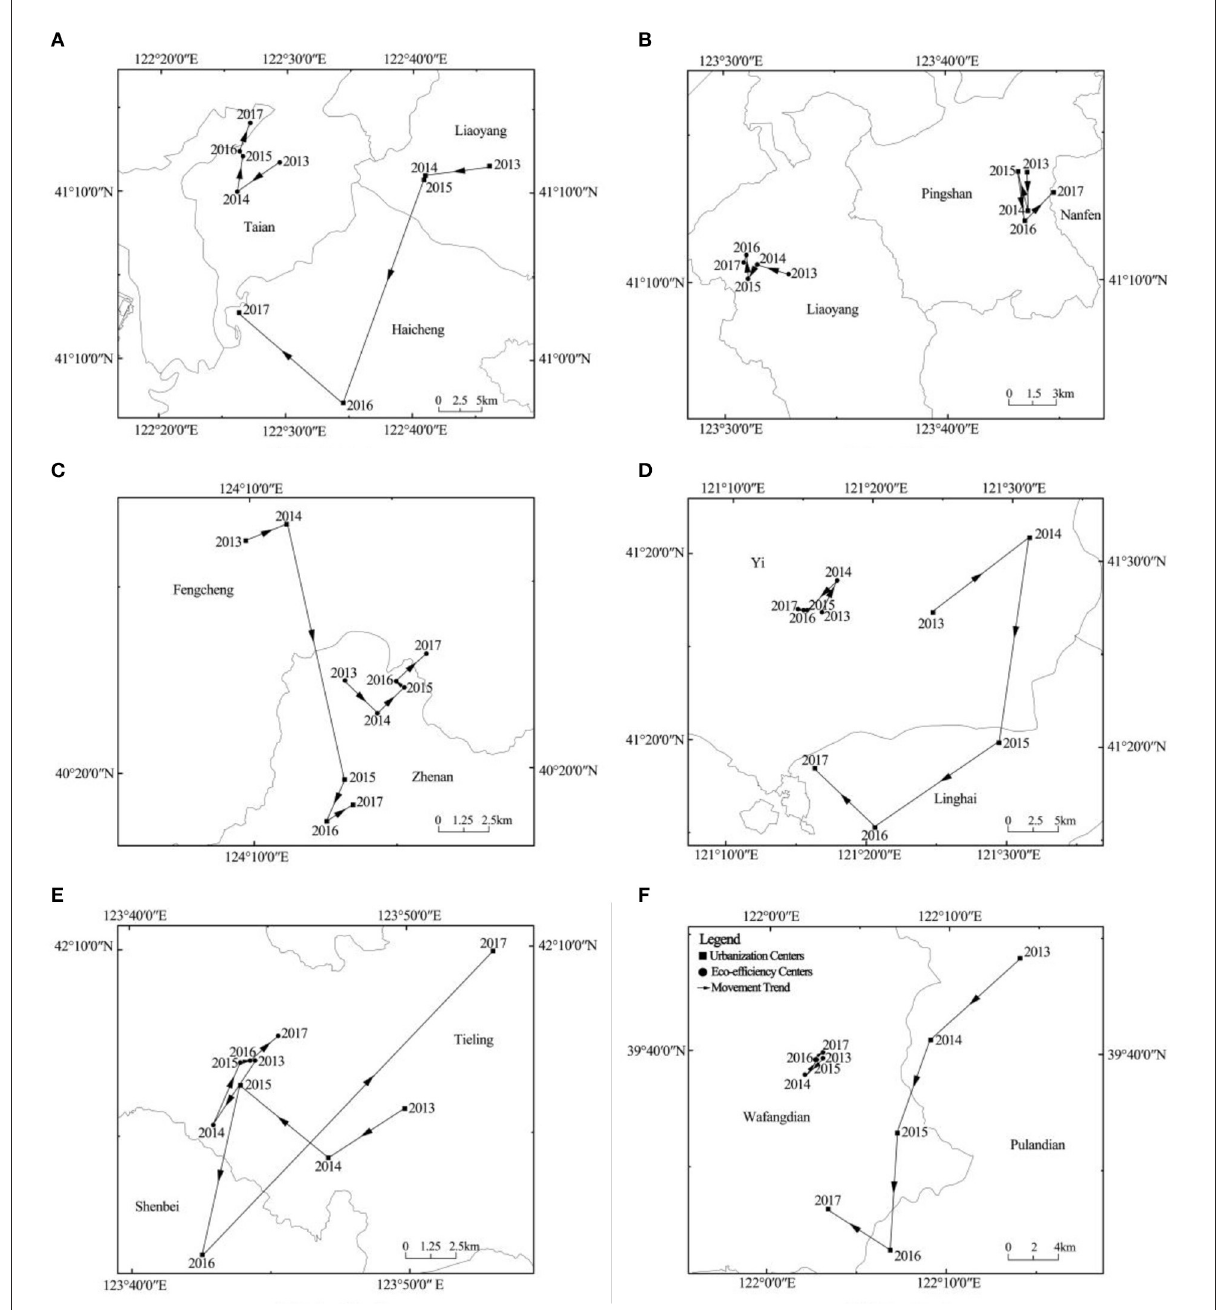
FIGURE5 Movement trend of urbanization and eco-efficiency centers of agricultural counties and districts in Liaoning province (2013–2017). (A) Liaoning province. (B) Central Liaoning. (C) Eastern Liaoning. (D) Western Liaoning. (E) Northern Liaoning. (F) Southern Liaoning.